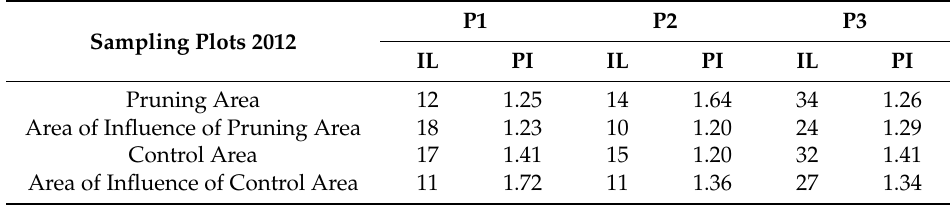
Table 2. Values of Infestation Level (IL) in %, and Population Intensity (PI) in average number of dry branches/tree, corresponding to each sampling area established inside each sampling plot (P1, P2, and P3) in